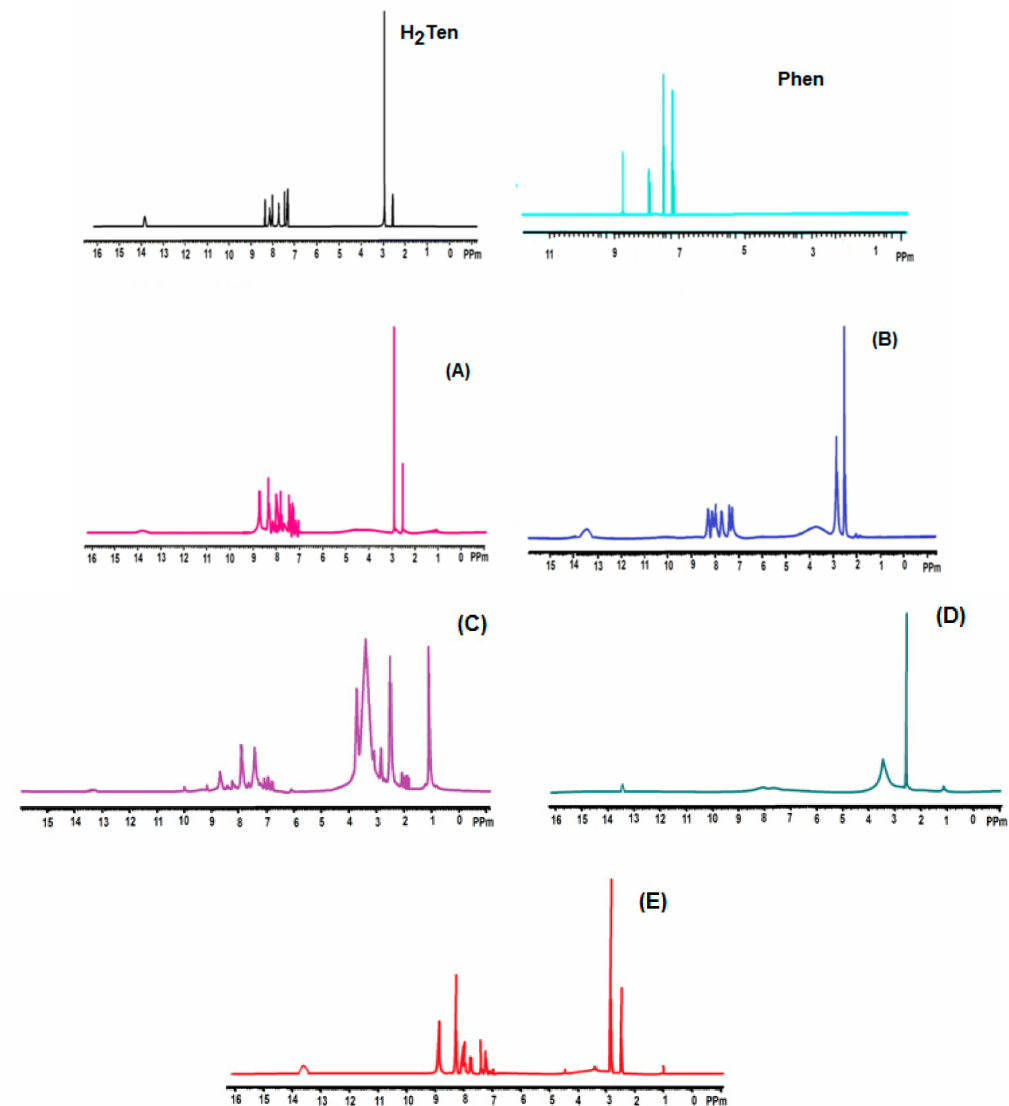
Figure 2. 1 H NMR spectrum for H 2 Ten, Phen and their metal complexes. Where: H 2 Ten: Tenoxicam; Phen: 1,10-Phenanthroline; ( A ) Manganese complex; ( B ) Cobalt complex; ( C ) Nickel complex; ( D ) Cupper complex; ( E ) Zink